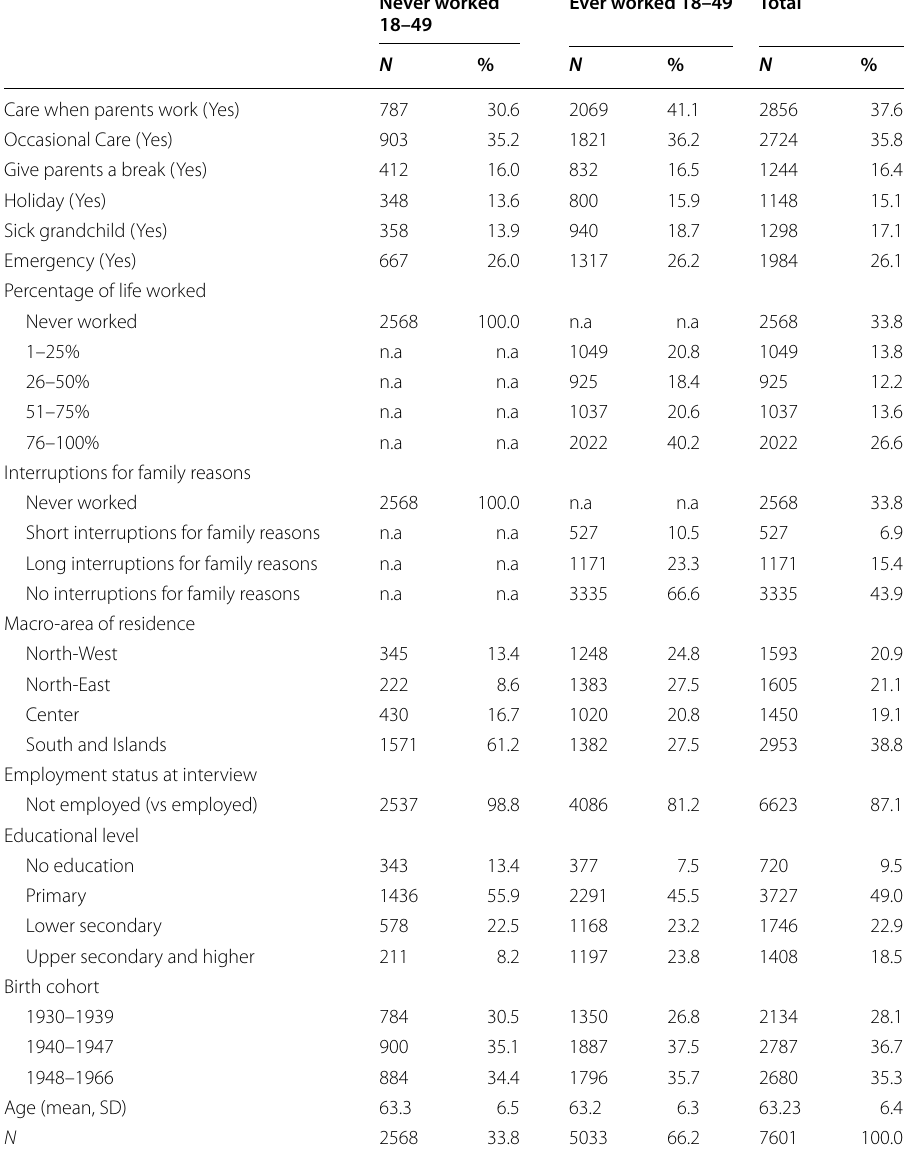
Table 2 Descriptive statistics, by employment history, absolute and percentage values (unweighted